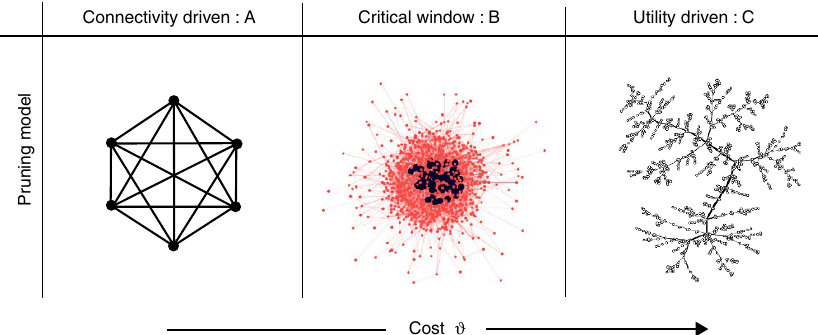
Figure 1 | Schematic representation of the network classes obtained by our algorithm. For vanishing cost, the network is fully connected (network A of six nodes—shown for simplicity) resembling the initial network. For significantly high cost, the network is tree-like, exhibiting no loops (network C of 10 3 nodes). In between, the proposed pruning process generates a network (network B of 10 3 nodes) with a core–periphery structure. The network in regime B was obtained for cost, W ¼ 0.92, corresponding to a peak in the core–periphery measure (details in the text). For the central network, the layout was generated by applying the Fruchterman–Reingold algorithm 23 . Colours show the difference in magnitude of coreness with black indicating the core and red, the